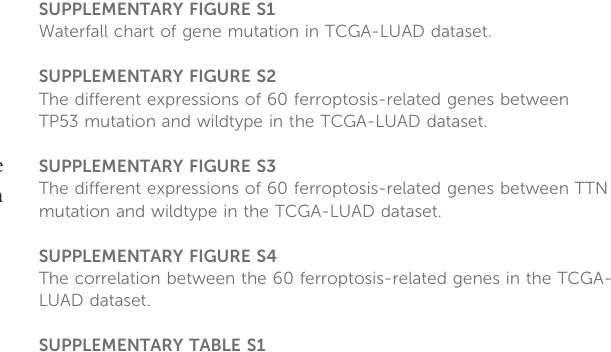
SUPPLEMENTARY FIGURE S1 Waterfall chart of gene mutation in TCGA-LUAD dataset. SUPPLEMENTARY FIGURE S2 The different expressions of 60 ferroptosis-related genes between TP53 mutation and wildtype in the TCGA-LUAD dataset. SUPPLEMENTARY FIGURE S3 The different expressions of 60 ferroptosis-related genes between TTN mutation and wildtype in the TCGA-LUAD dataset. SUPPLEMENTARY FIGURE S4 The correlation between the 60 ferroptosis-related genes in the TCGA- LUAD